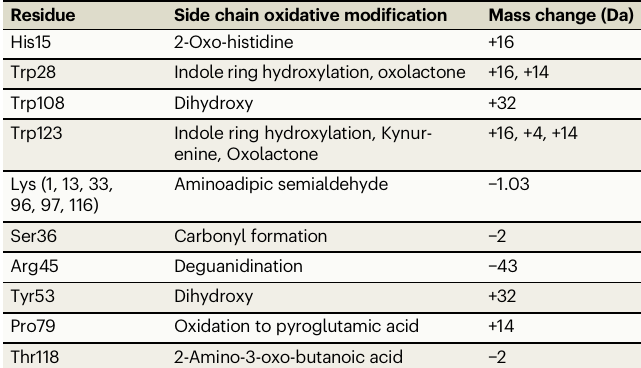
Table 4 | Side-chain oxidative modi fi cations found on the intact HEWL after reaction with Cu II WD/Asc and the corresponding mass